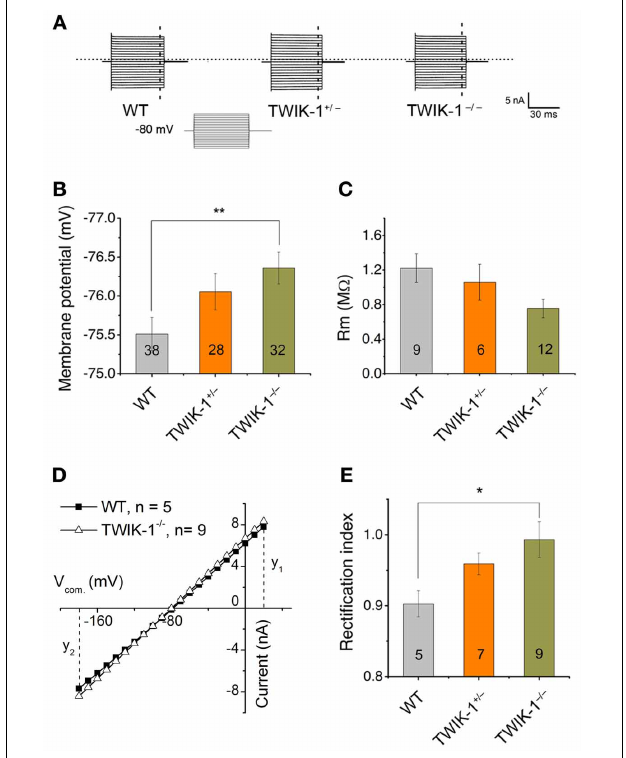
FIGURE 3 | TWIK-1 gene deletion alters the membrane properties of astrocytes. (A) Representative whole-cell currents of three genotypes. Cells were held at − 80mV at resting and the membrane currents were induced by command voltages from − 180 to + 20mV with 10mV increment ( inset , command voltages, Vcom). Astrocytes in all genotypes showed a similar linear I–V relationship membrane conductance. (B), (C) TWIK-1 gene deletion hyperpolarized astrocyte membrane potential (Vm, B ), but did not significantly alter the membrane resistance (Rm, C ). (D) To construct I–V curves, the current amplitudes from the dashed vertical lines in (A) were plotted against their corresponding Vcom. The current amplitude at y1 (V 20mV ) and y2 (V − 180mV ) were used to calculate RI according to equation [1] (see Methods). (E) The RI values shifted from weakly inward rectification in WT to close to linear in TWIK-1 − / − astrocytes in a gene dependent manner. Data are shown as mean ± SEM, ∗ p < 0 . 05, ∗∗ p < 0 .